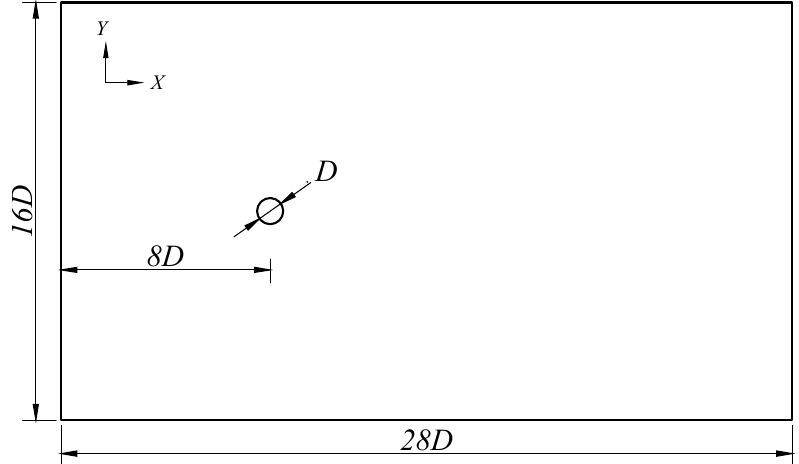
Figure 3. Simulated two-dimensional flow